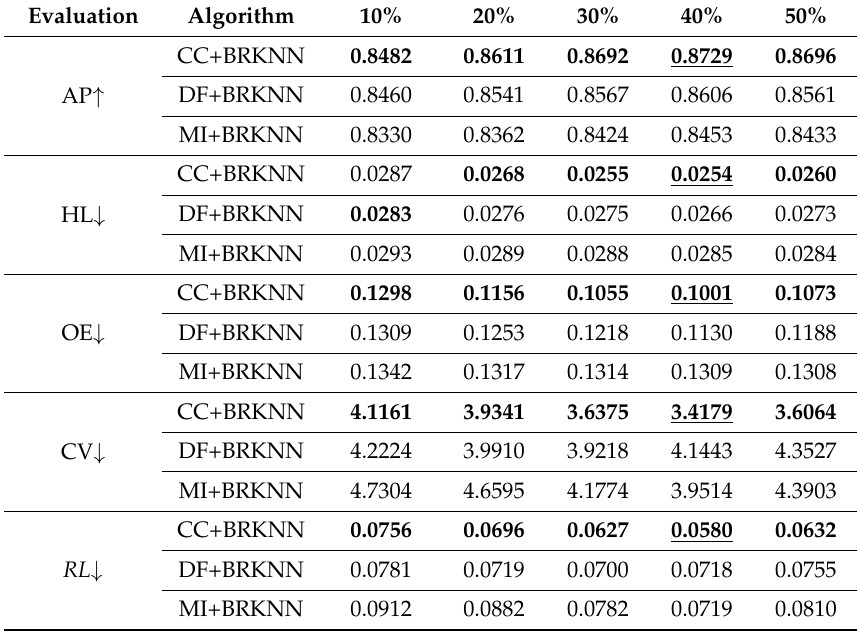
Table 10. Comparison of classification performance on Business data set.